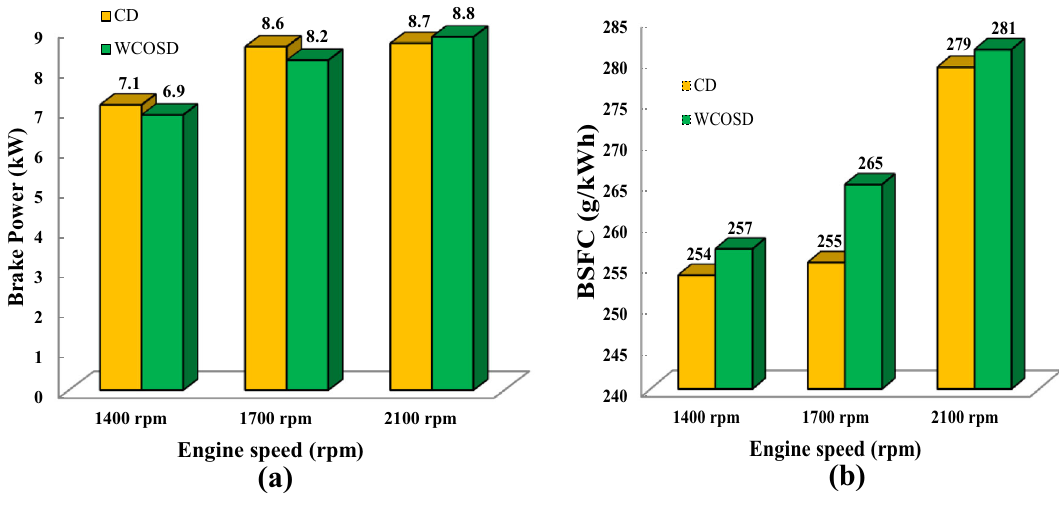
Fig. 3 Comparison of engine characteristics a engine power and b fuel